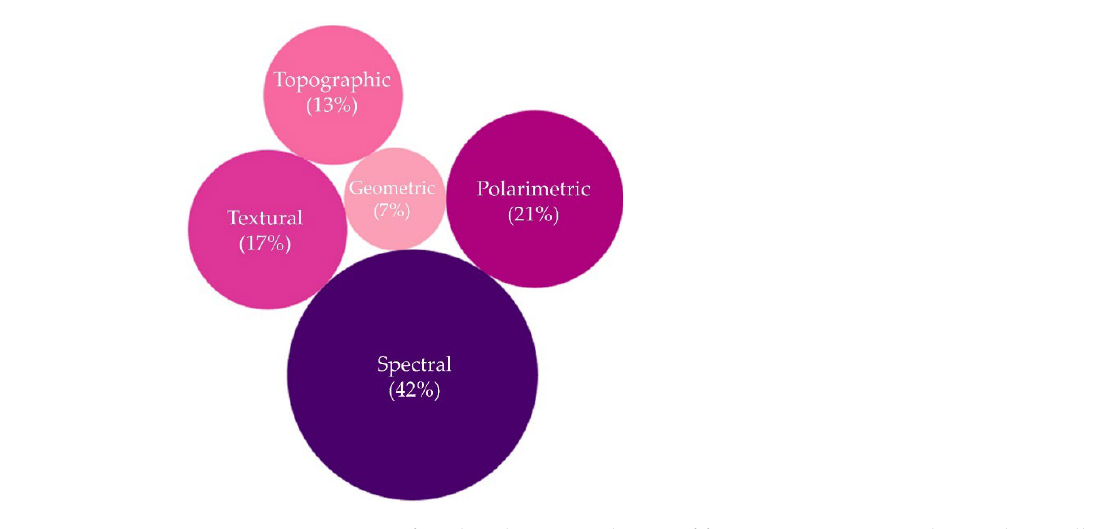
Figure 18. Percentage of studies that use each type of feature category. Note that as almost all studies have used either optical or SAR imagery features, the category of imagery features was excluded here.